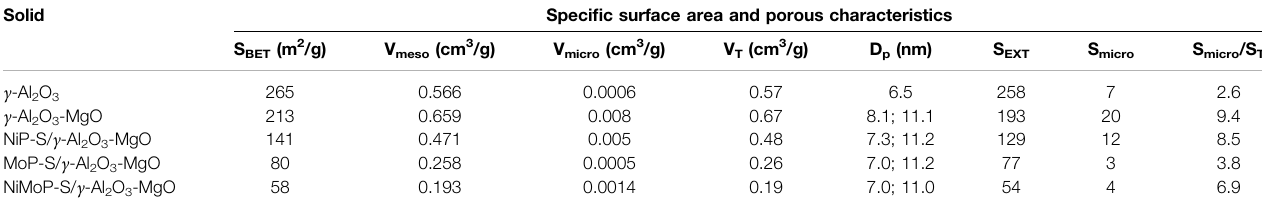
TABLE 2 | Textural properties of the Al 2 O 3 -MgO supported NiMo mixed phosphidic-sulphidic phase. Solid Speci fi c surface area and porous